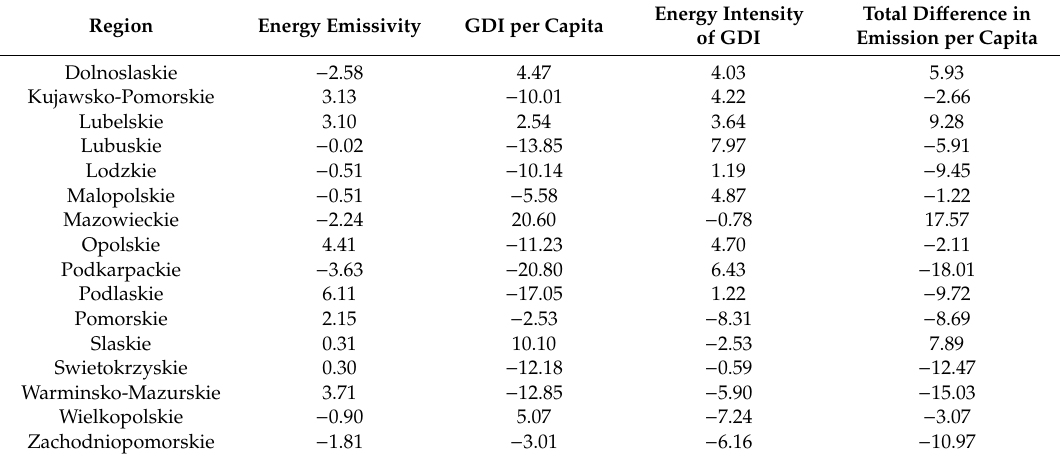
Table 7. Contribution of factors to the di ff erence in CO 2 emission per capita in households in 2017 [percentage points]. Source: Own